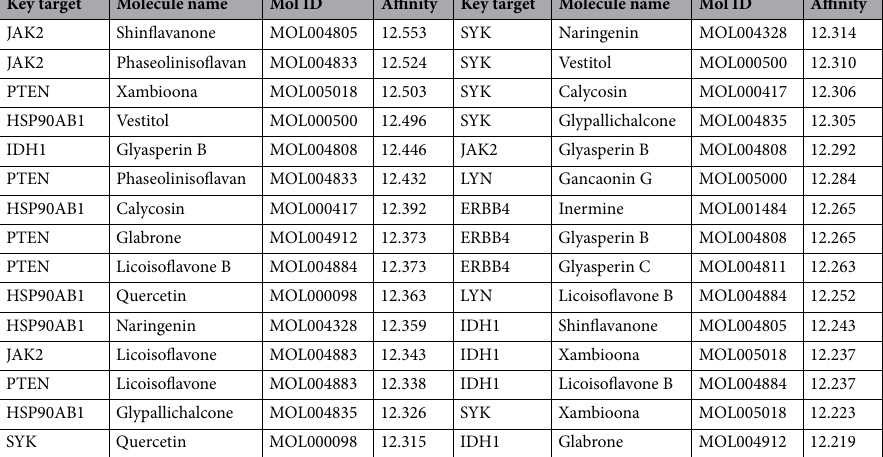
Table 3. Top 30 drug-target pairs obtained by the P2 process.